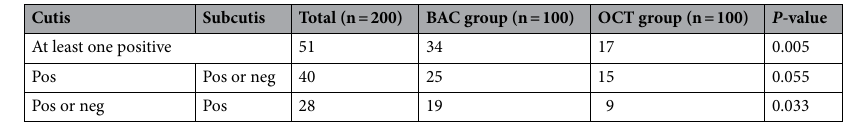
Table 2. Comparison of the number of bacteria detections in cutis and subcutis between the alcohol-based antiseptic with additional benzalkonium chloride (BAC group) and the antiseptic with additional octenidine dihydrochloride (OCT group). Pos = positive bacteria detection; Neg = negative bacteria detection.